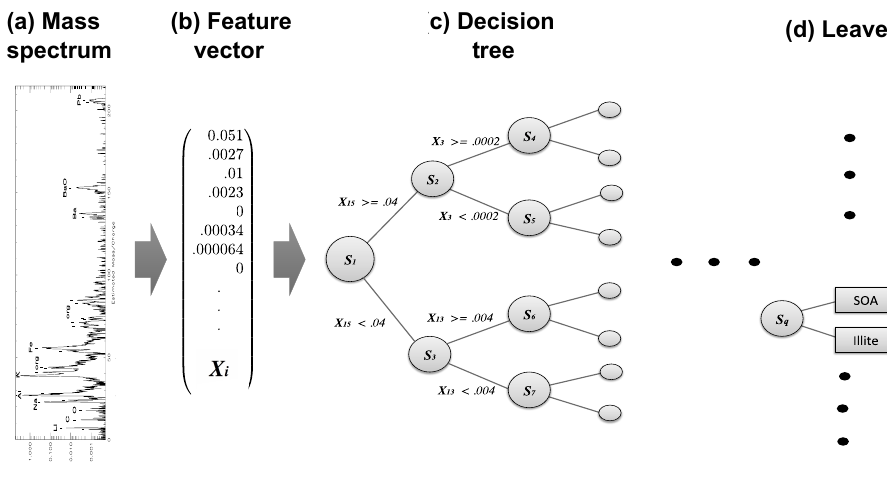
Figure 2. Schematic of decision tree classification for a single aerosol spectrum. From left to right, a mass spectrum is normalized with respect to total ion current, forming the elements of normalized feature vector X . A trained decision tree then applies a series of tests to a discreet number of peaks in order to arrive at a categorical aerosol prediction (the